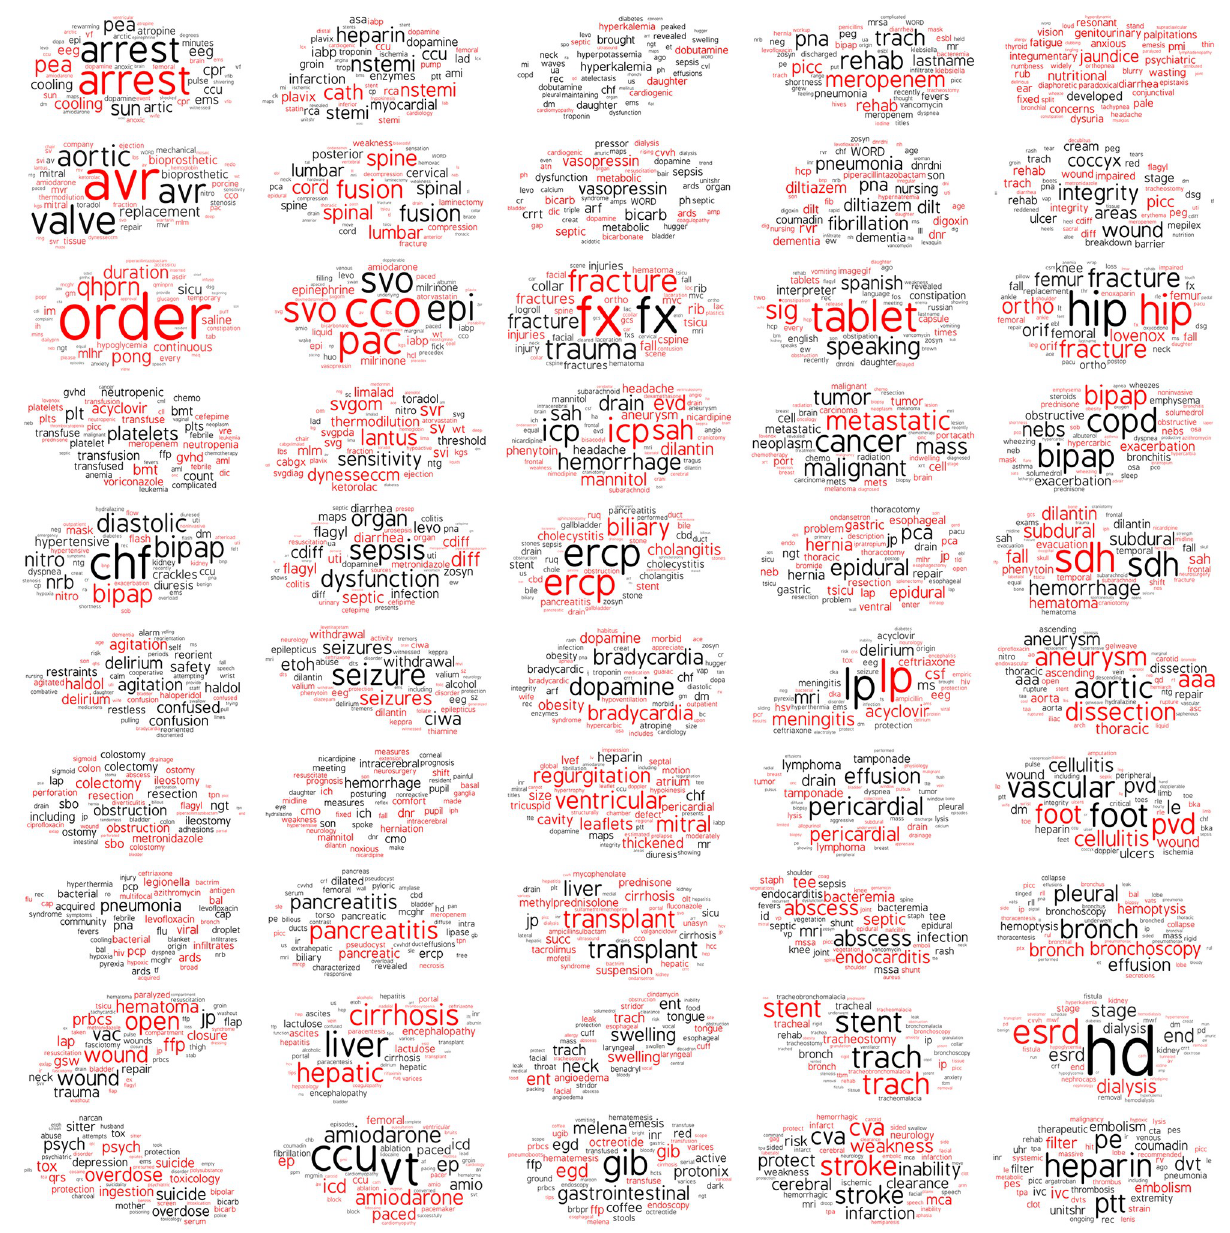
Fig 3. Word clouds of the 50 topics from multi-note model. Red indicates the words written by physicians and black indicates the words written by nurses.